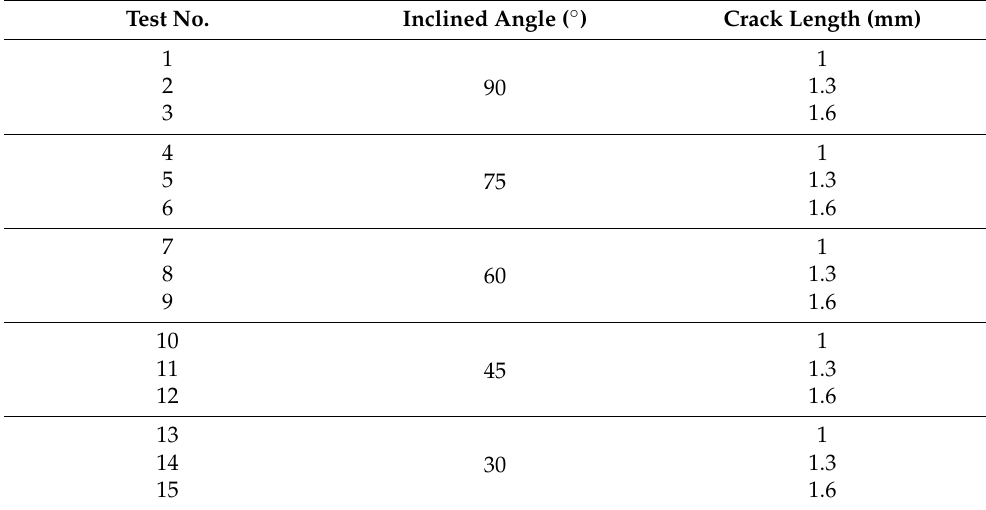
Table 1. Crack parameter